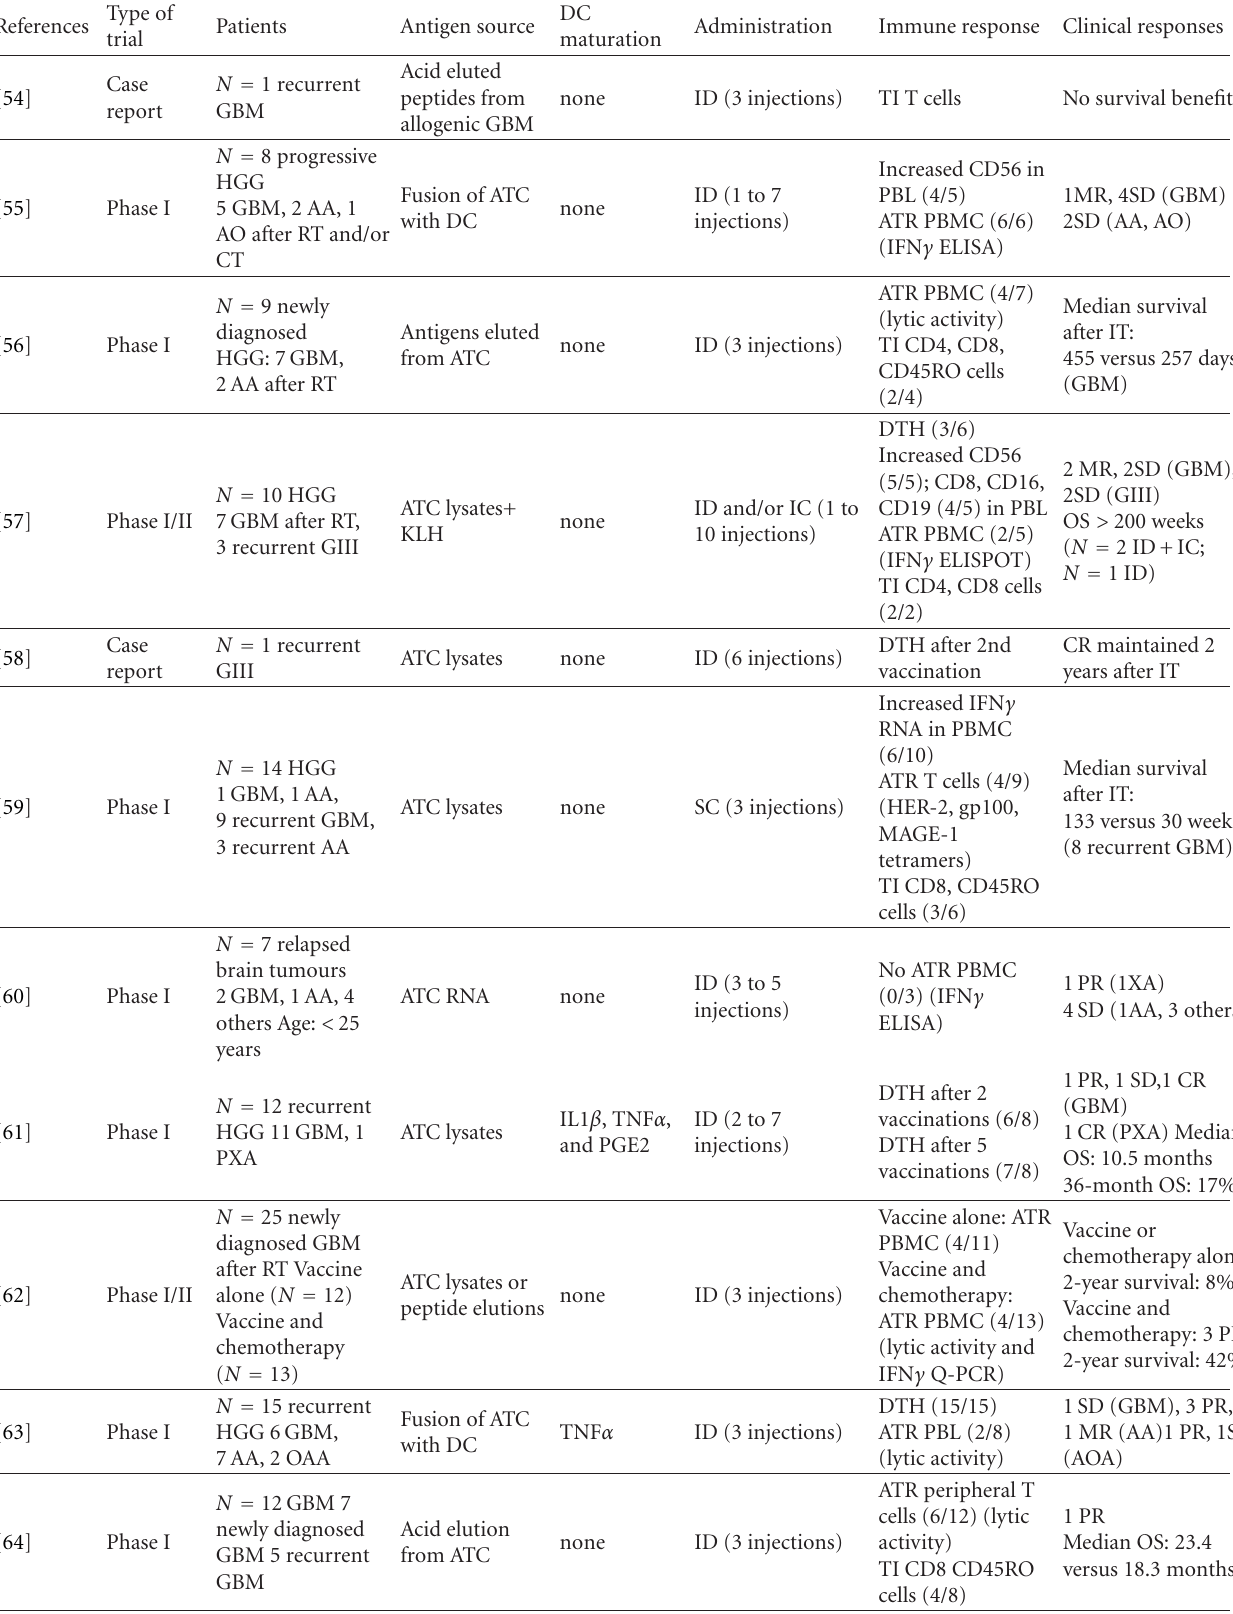
Table 4: Active immunotherapy in high grade gliomas using dendritic cells (DCs) ∗